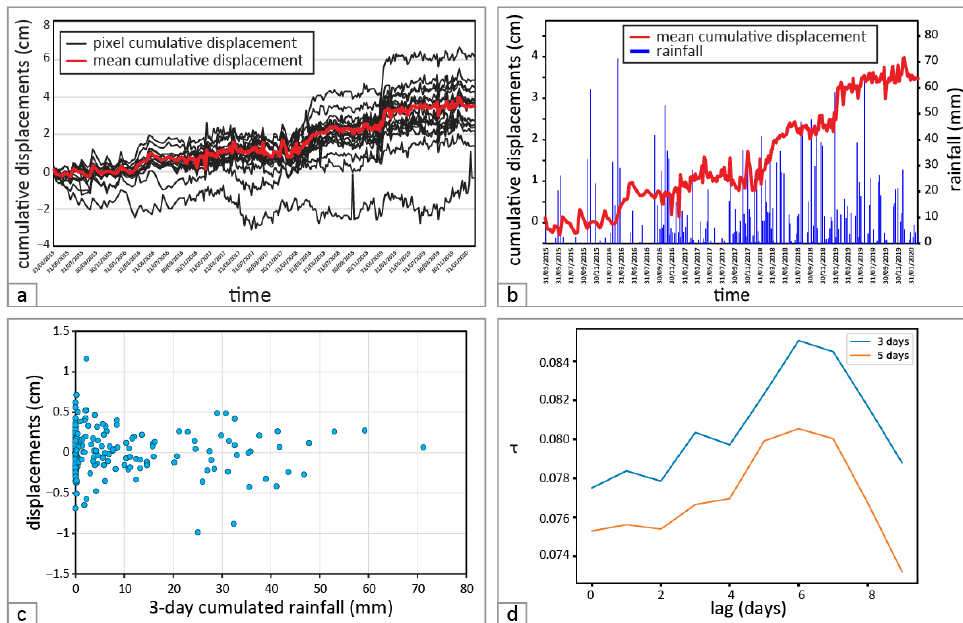
Figure 9. Example of the results obtained for the rotational slide (Figure 7), for the T124 descending orbit: ( a ) cumulative displacements measured over the whole observation period (black curves) with the indication of the average displacements representative for the landslide (red curve); ( b ) representative cumulative displacements and 3 ‐ day cumulative rainfall; ( c ) scatter plot of the relative displacements and the 3 ‐ day cumulative rainfall; ( d ) values of the Kendall coefficient, τ , measuring the ordinal association between rainfall series and relative displacements with different shifts (lag from 0 to 10 days); only the rainfall series that satisfied the hypothesis of a p < 0.1 are shown (in this case only the series of 3 ‐ day and 5 ‐ day cumulative rainfall).